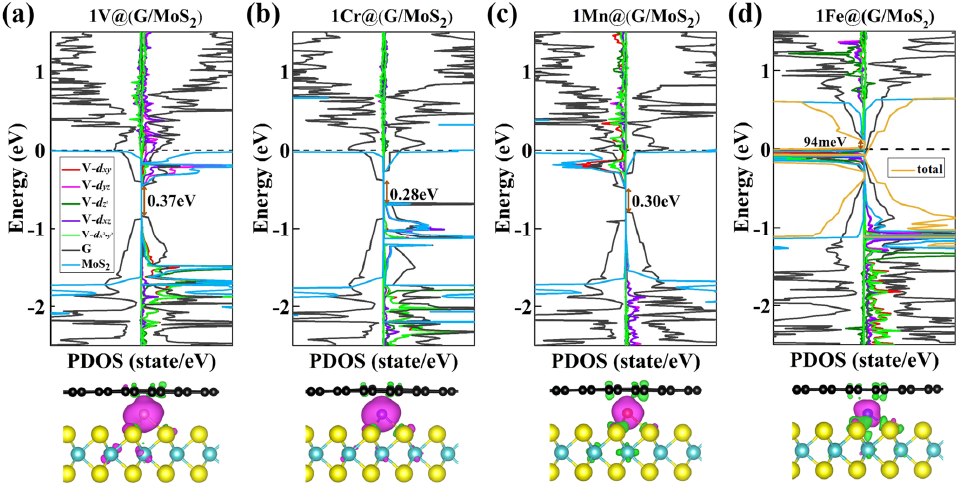
Figure 2. ( a – d ) Partial density of states (PDOS) and spin density plots for 1TM@(G/MoS 2 ) (TM = Ti, V, Cr, Mn). The left and right panels of every PDOS plot are the minority- and majority-spin channels, respectively.